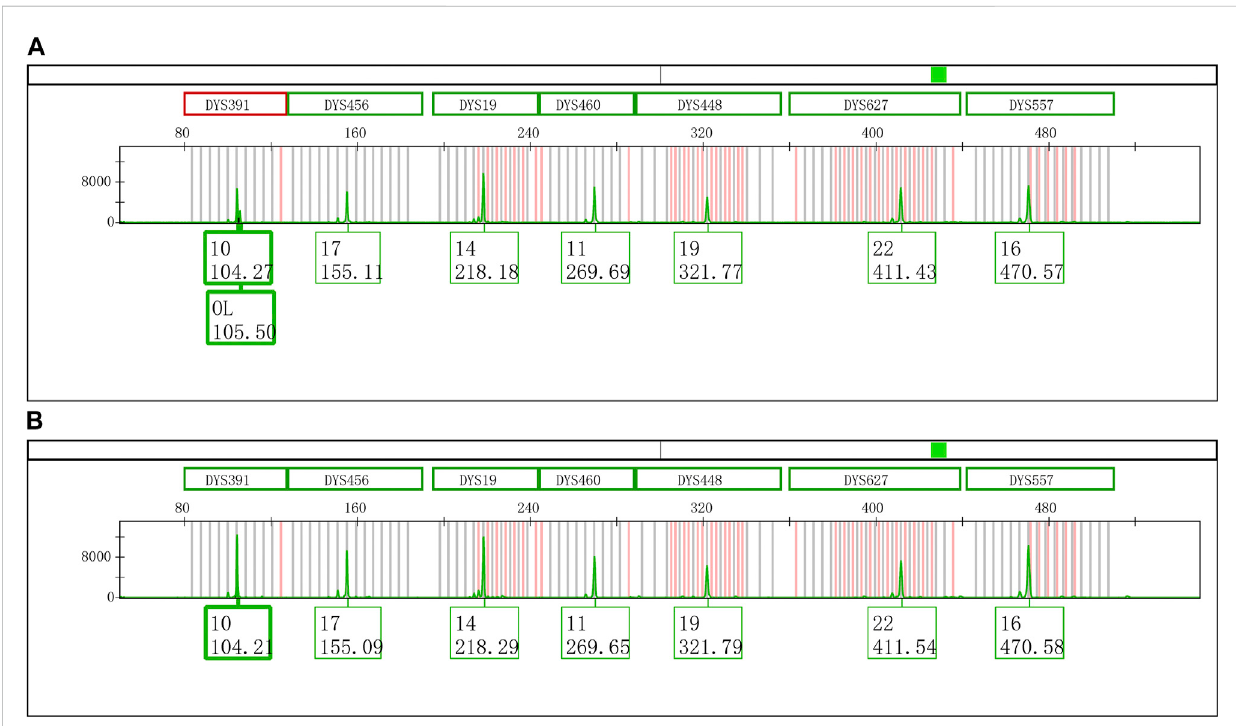
Electrophoretogram results of the green dye channel in Y43CS. (A) The allelic peak of locus DYS391 with an extra peak of 105.50 bp. The extra peak waslocatedontherightsideofallele10atlocusDYS391.Thepeakheightsofallele10andextrapeakwere6756RFUand2296RFU,respectively,andthe peakheightratioofextra peaktoallele10was0.3398. (B) The typicalallelicpeakoflocusDYS391. Thesize ofpeakwas104.21bp,andlabeledas allele10 with a height of 12496